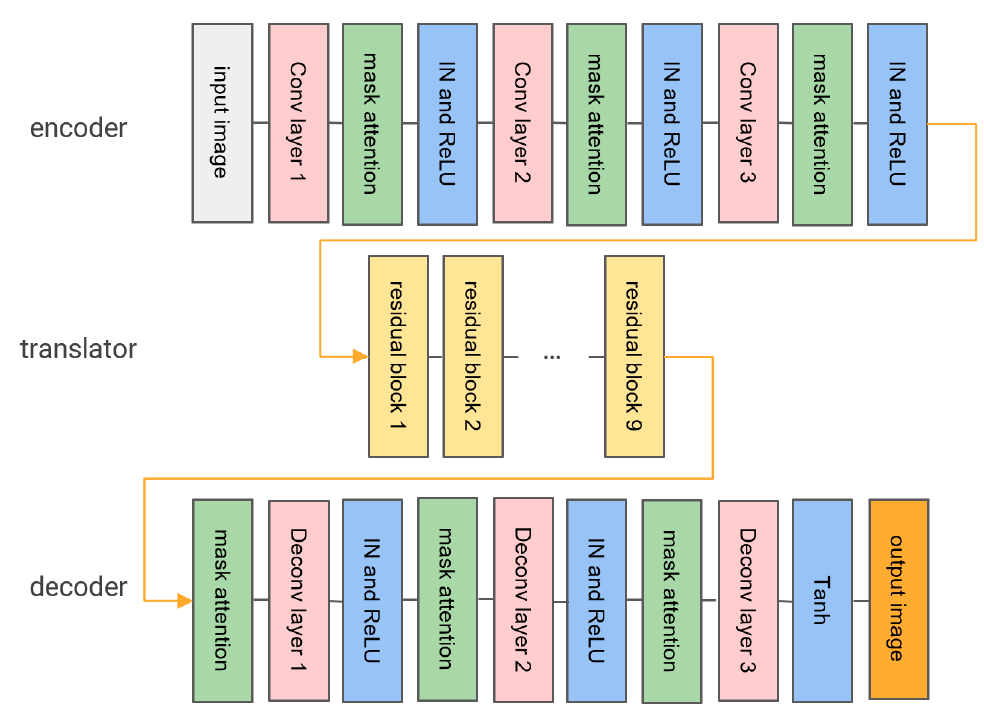
Figure 4. Schematic diagram of the model framework of the GMA-CycleGAN generator based on mask attention.